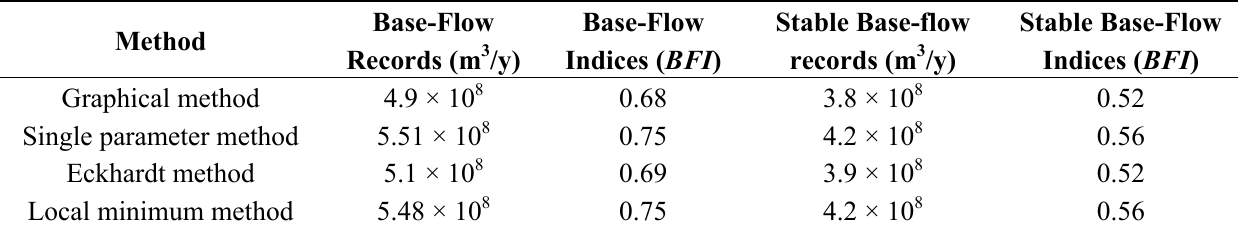
Table 1. Annual base-flow records, stable base-flow and their base-flow indices.